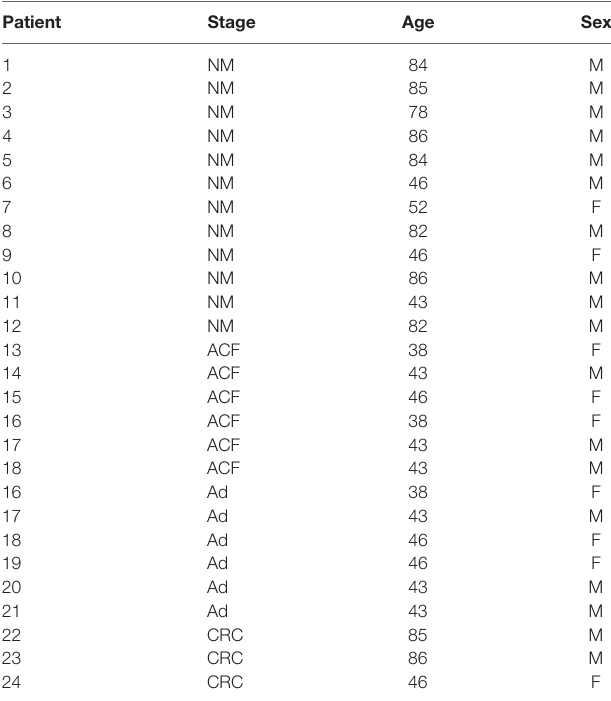
TaBle 1 | Demographic characteristics and tumor stage in samples obtained from NM, ACF, Ad, or CRC. Patient stage age sex